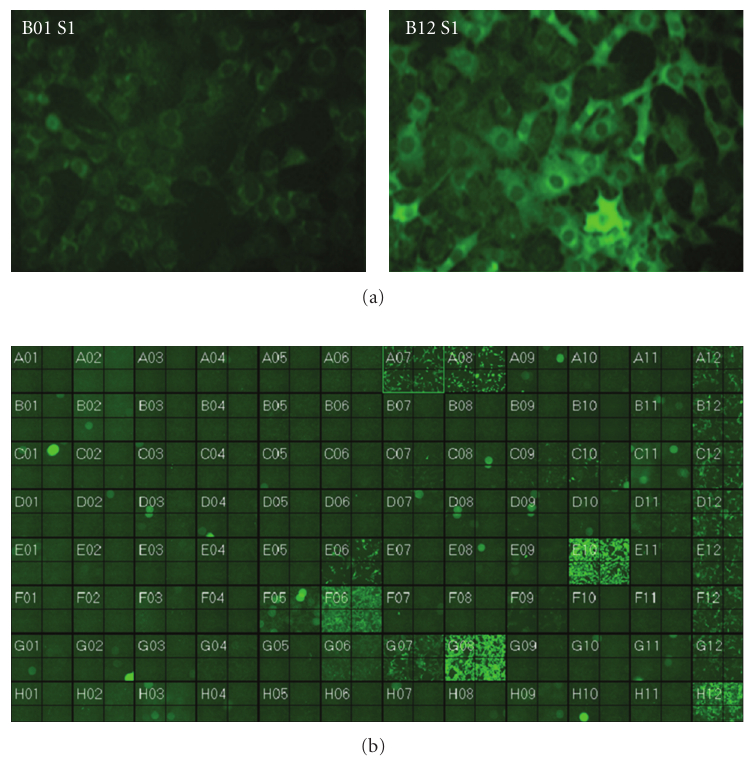
Figure 4: Transgenic LDR cells used in a low-throughput drug screen. (a) Highly responsive cells chosen for the assay were expanded clonally, showing 70%–90% response to 25mM butyrate (right), as compared to vehicle treated cells (left). (b) A 96-well plate used to screen compounds from the NCI structural diversity library was visualized after treatment with 4 µ M compounds in DMSO, using a Discovery 1 fluorescent microscope platform and processed on the fly for 2 × 2 visualization per well. Hits are easily detectable by marked increase in fluorescence. Parental untransfected mouse mammary adenocarcinoma cells were used to counter